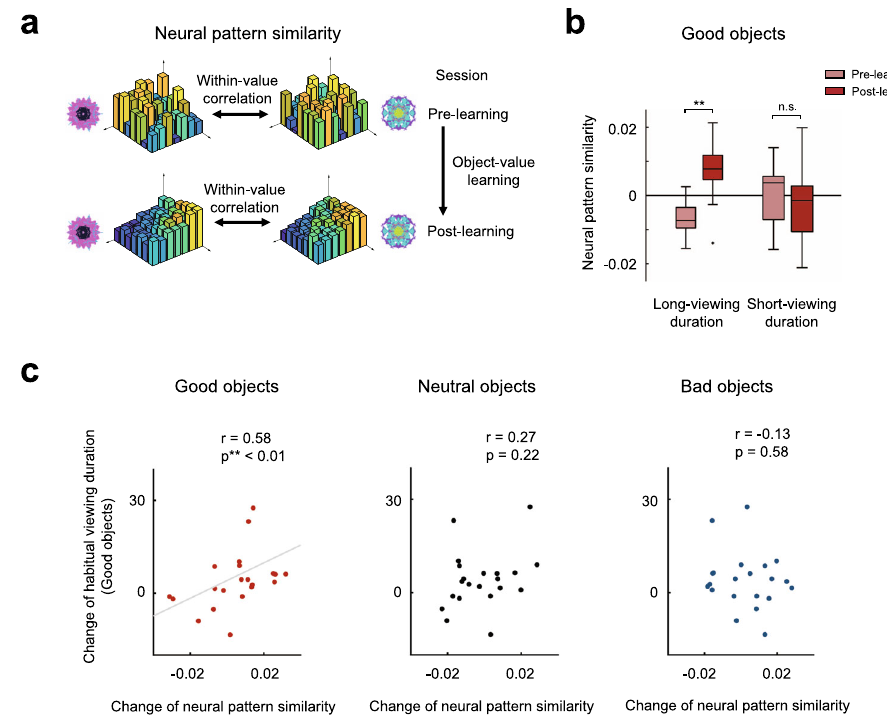
Fig. 5 Representations of objects before and after learning in the human ventral striatum. a Calculations of neural pattern similarity levels. The within- value correlations were calculated for all possible pairs of good (or neutral or bad) objects, based on the response patterns during the Pre-learning and Post-learning fMRI sessions. b Neural pattern similarity during the Pre-learning and Post-learning fMRI sessions for the long-viewing-duration (left) and short-viewing-duration (right) participant groups in the free-viewing task. The neural pattern similarity for good objects increased signi fi cantly after learning in the long-viewing-duration group ( n = 11 participants, two-tailed paired t test, ** p = 0.002) whereas no change was found in the short-viewing duration group ( n = 11 participants, two-tailed paired t test, p = 0.654). n.s. not signi fi cant. The middle line indicates the median, and the bottom and the top of the box correspond to the 25th and 75th percentiles, respectively. The upper and lower whiskers extend to the highest and lowest values that are within 1.5 times interquartile range of the hinge. Outlying data beyond this are plotted as dots. c Relationship between the performance on the free-viewing task and the neural pattern similarity for good, neutral, or bad objects. The change in the neural pattern similarity for good objects, but not for neutral or bad objects, was signi fi cantly correlated with the change of the viewing duration for good objects ( n = 22 participants, Spearman ’ s rank correlation, two- tailed, ** p =